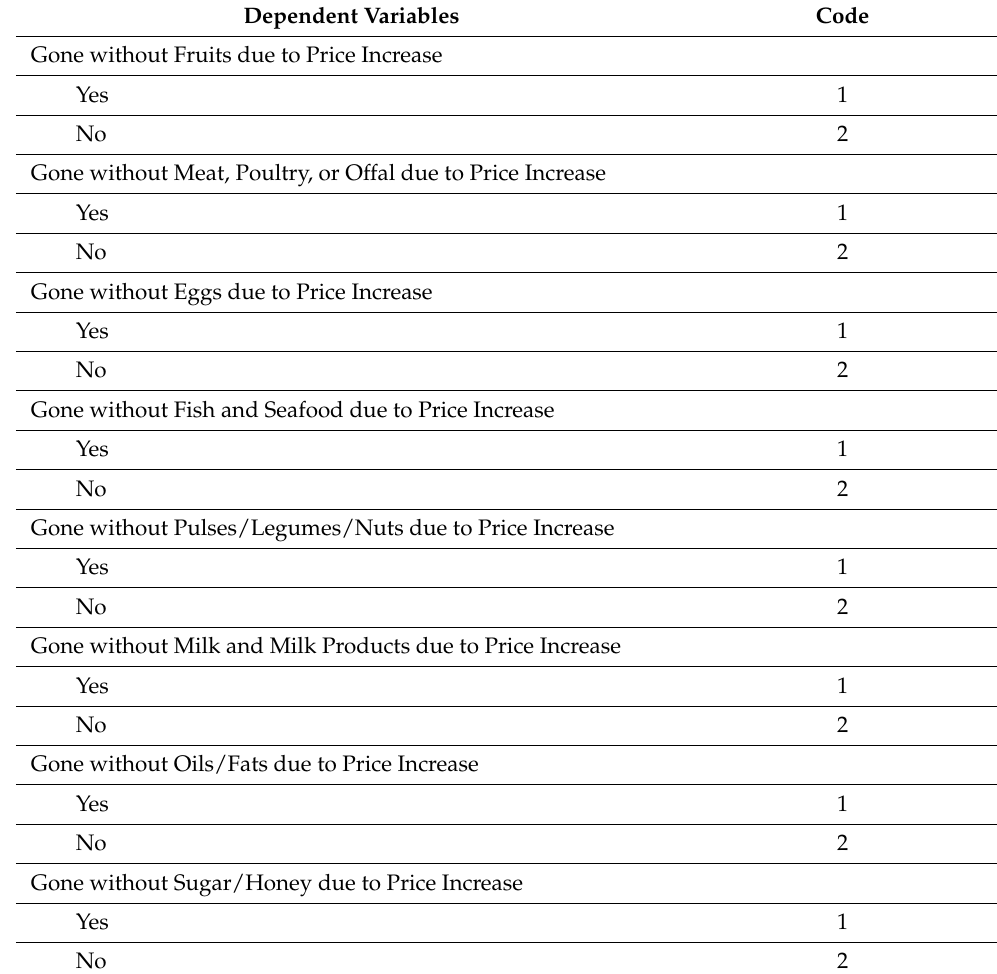
Table 3. Cont. Dependent Variables